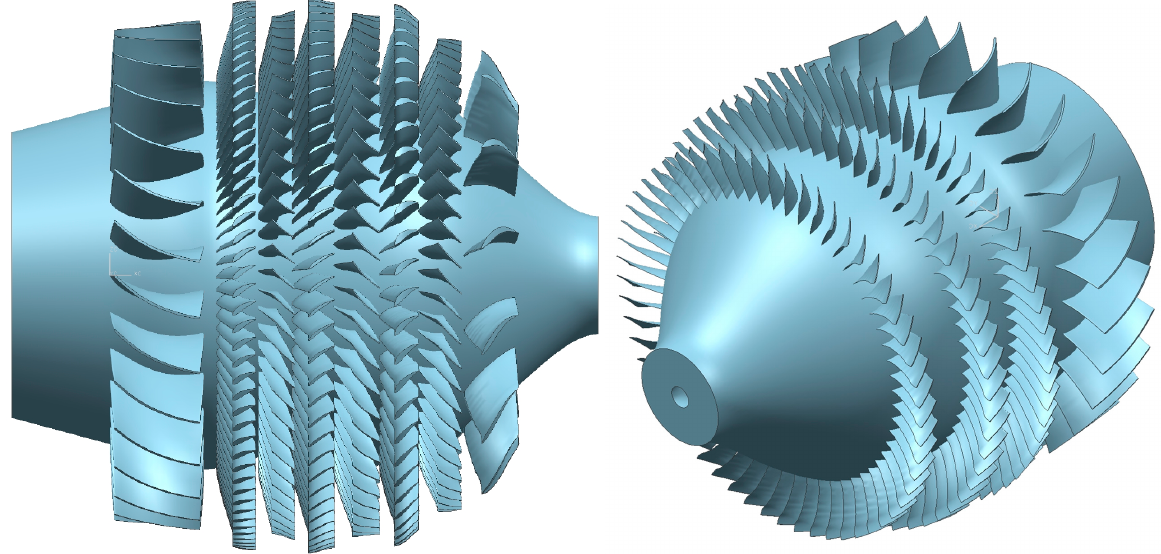
Figure 12. 3D CAD view of one of the axisymmetric optimum designs for LPC with fan stage.